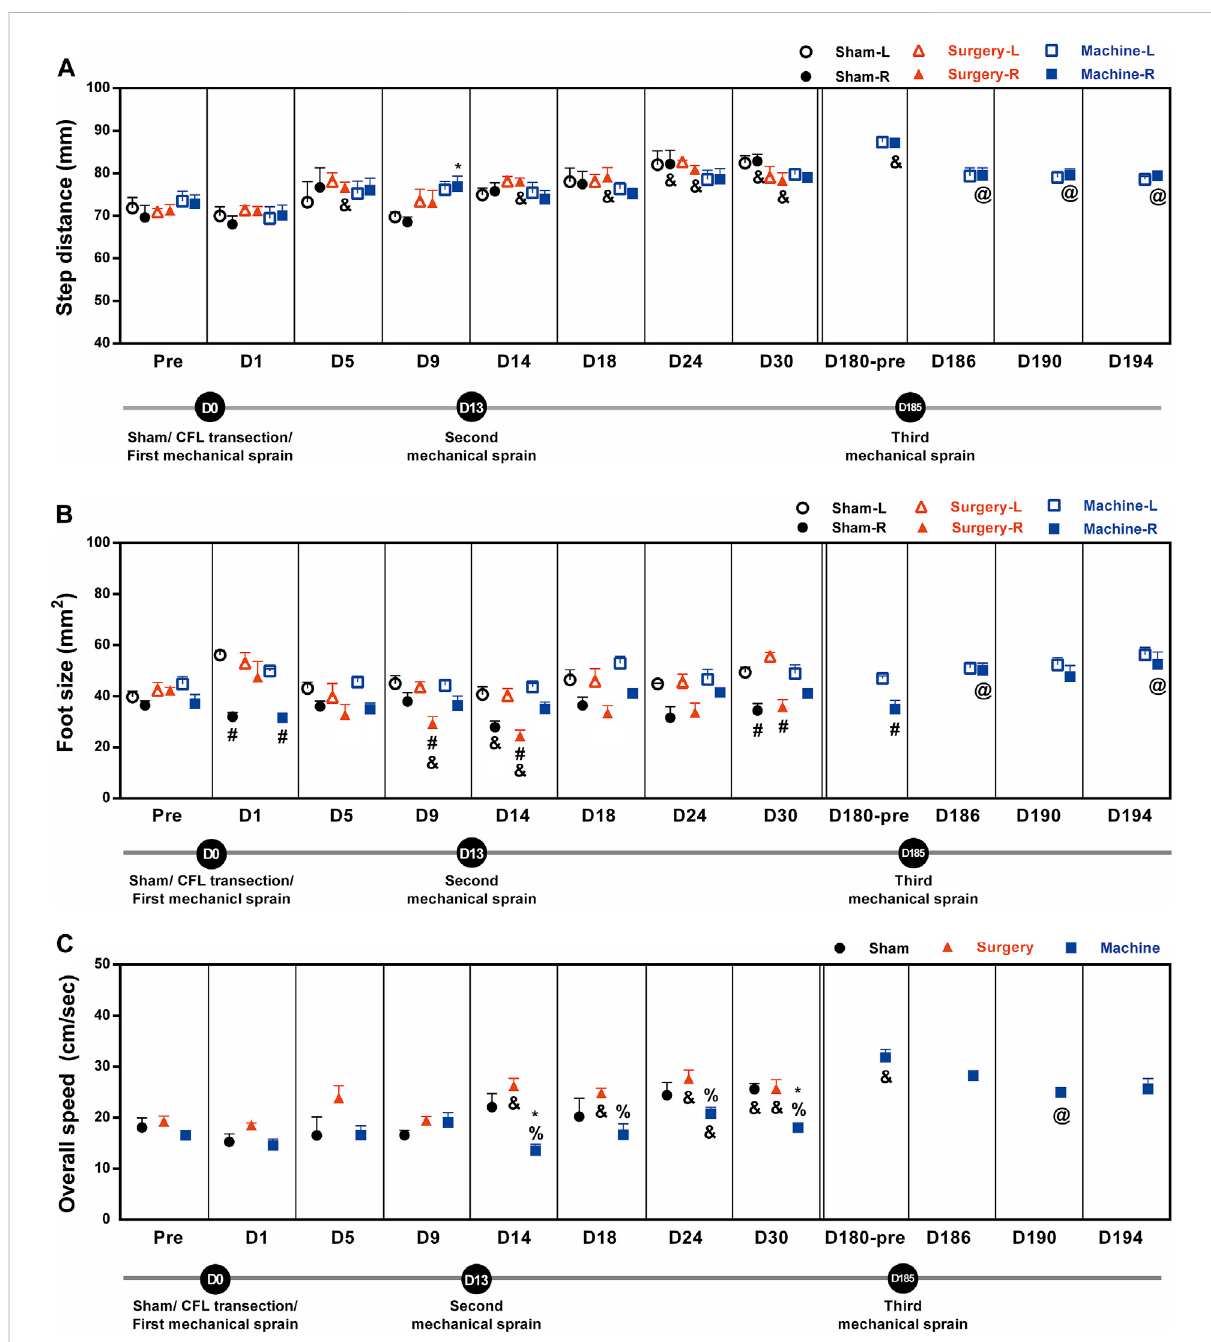
FIGURE 6 Mechanical ankle sprains induces gait abnormalities in step distance, foot size, and overall speed. Footprint was measured and analyzed on the days indicated on the graphs after sham operation, CFL transection, and three mechanical ankle sprains to obtain gait parameters including step distance (A) , foot size (B) , and overall speed (C) . Values are mean ± SEM, n = 4. The statistical signi fi cance was analyzed between groups using un- paired t test (* and %) or within group using paired t test (#, @, and & ) * p < 0.05 compared with right foot (R) of sham operation group; % p < 0.05 compared with the right injured foot of the surgical transection group; # p < 0.05, a signi fi cant difference between the right injured and the left untreated foot (L) in each group; & p < 0.05 compared with the corresponding pretreatment (pre) baseline; @ p < 0.05 compared with